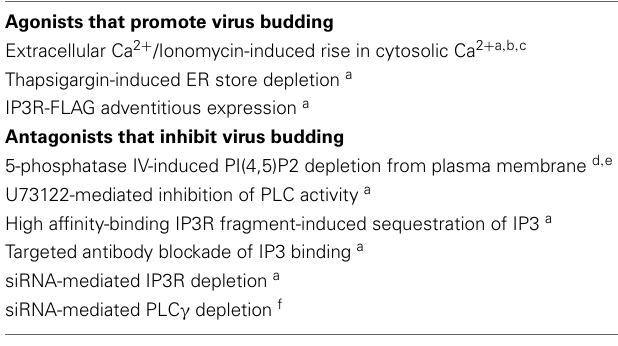
Table 1 | Observations Linking HIV-1 Budding to PI(4,5)P 2 -PLC-IP3-IP3R-Ca 2 + Signaling